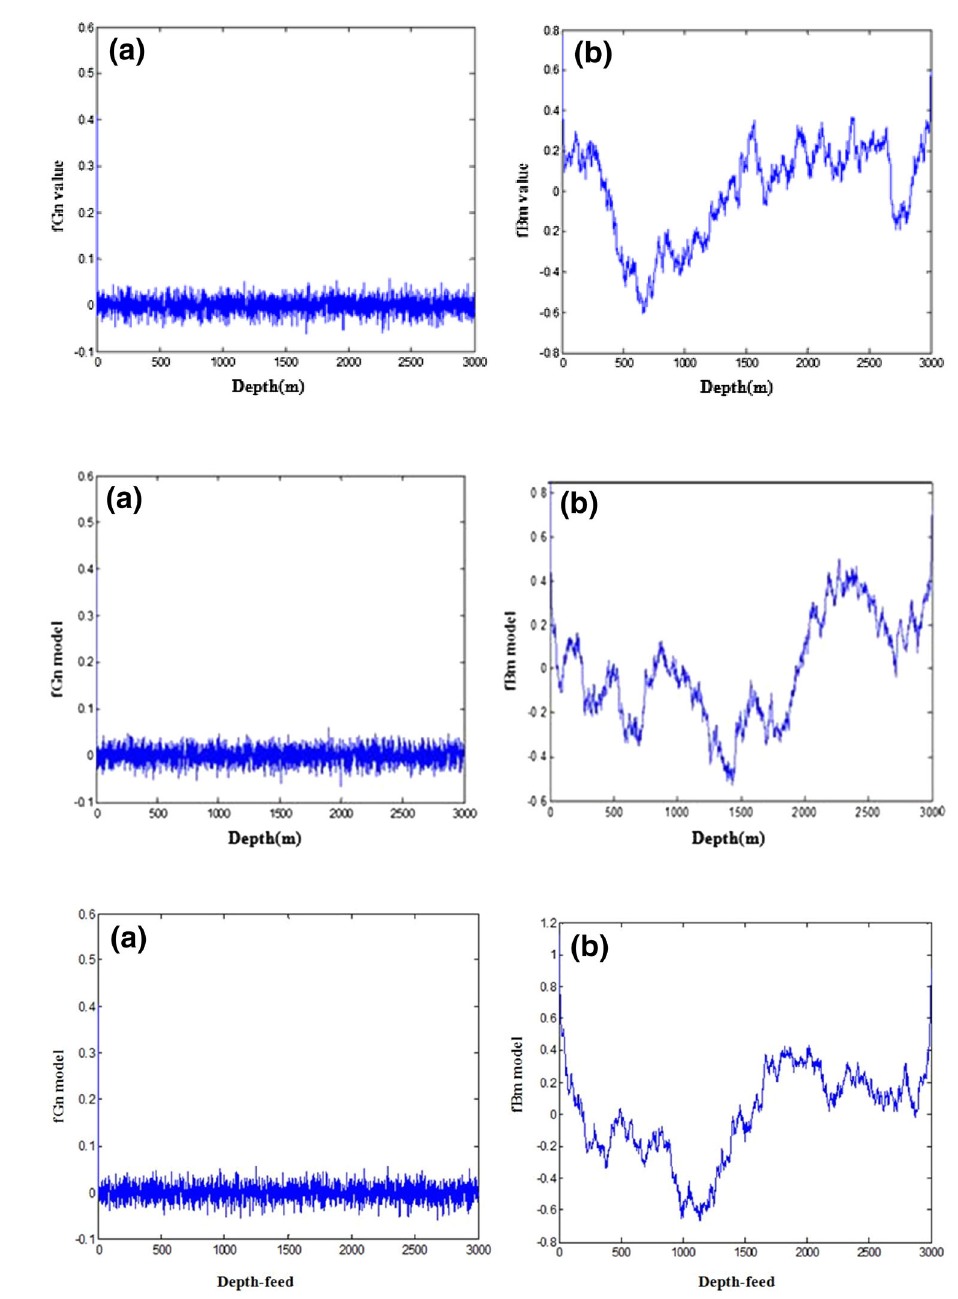
Fig. 5 Two realizations with fractal structure for well log porosity in well A;